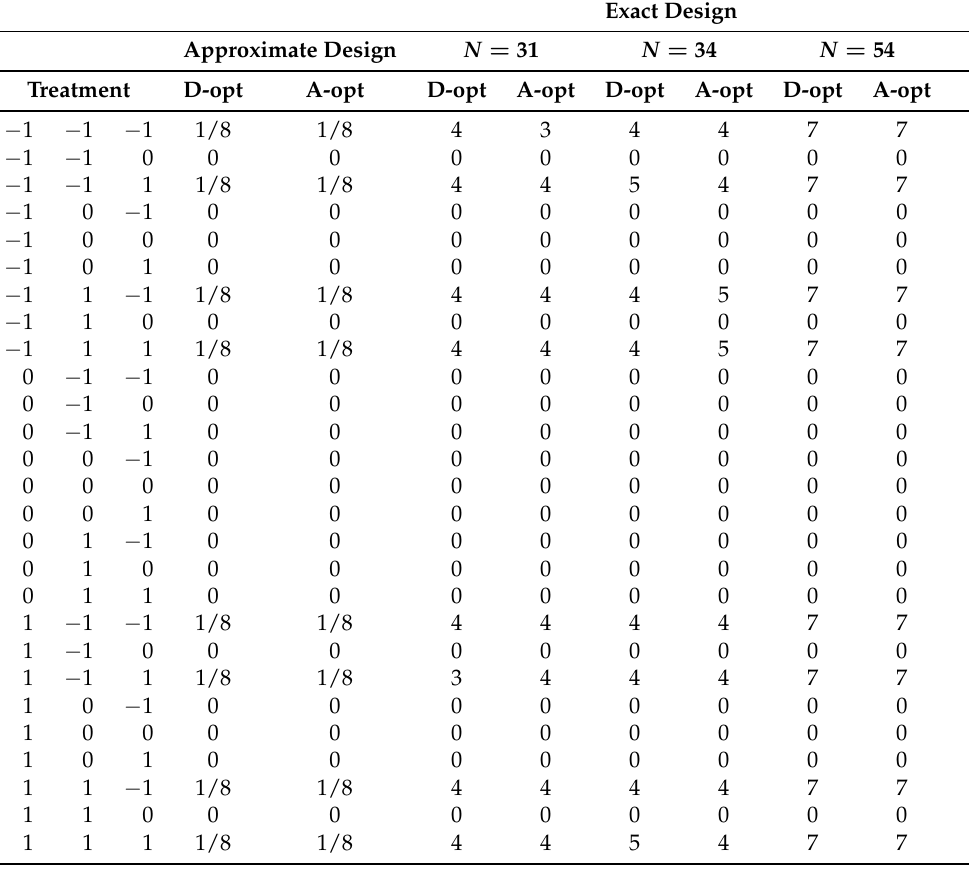
Table 5. D- and A-optimal designs for Model 4, where k = 27 and N = { 31,34,54 }